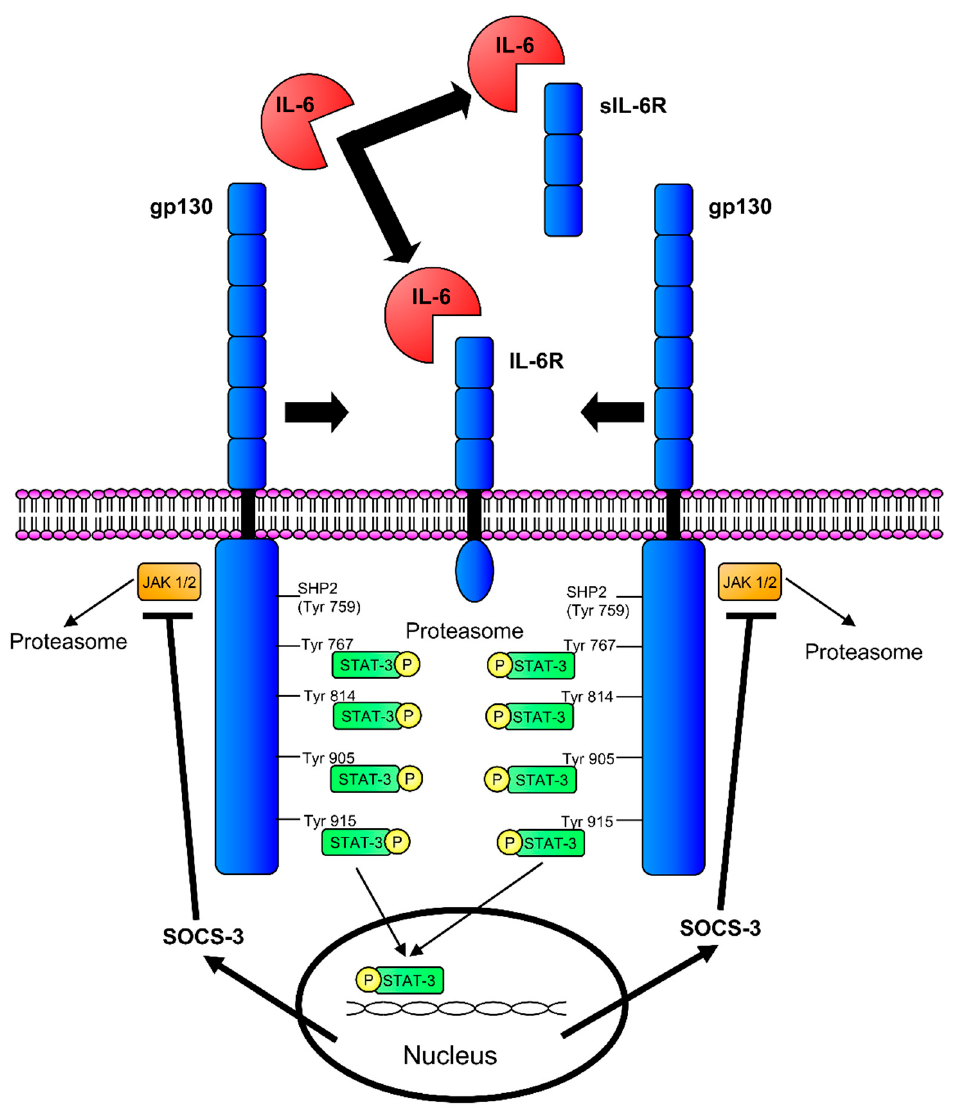
Figure 1. IL-6 signalling. IL-6 can signal by first binding to the membrane bound IL-6R or soluble IL-6R (sIL-6R). After recruitment of the gp130 receptors, Janus kinase (JAK)/STAT signalling occurs on the intracellular domains of the gp130 receptors. Suppressor of cytokine signalling-3 (SOCS-3) can inhibit JAK/STAT signalling on the gp130 receptors by binding the Src Homology Phosphatase 2 (SHP2)/Tyrosine (Tyr) 759 binding sites.